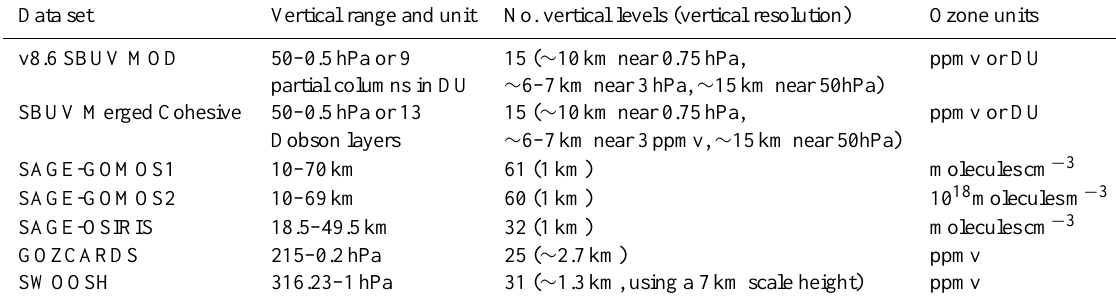
Table 2. Summary of the vertical range, units, and number of levels, as well as the ozone units of each of the seven data sets. Data